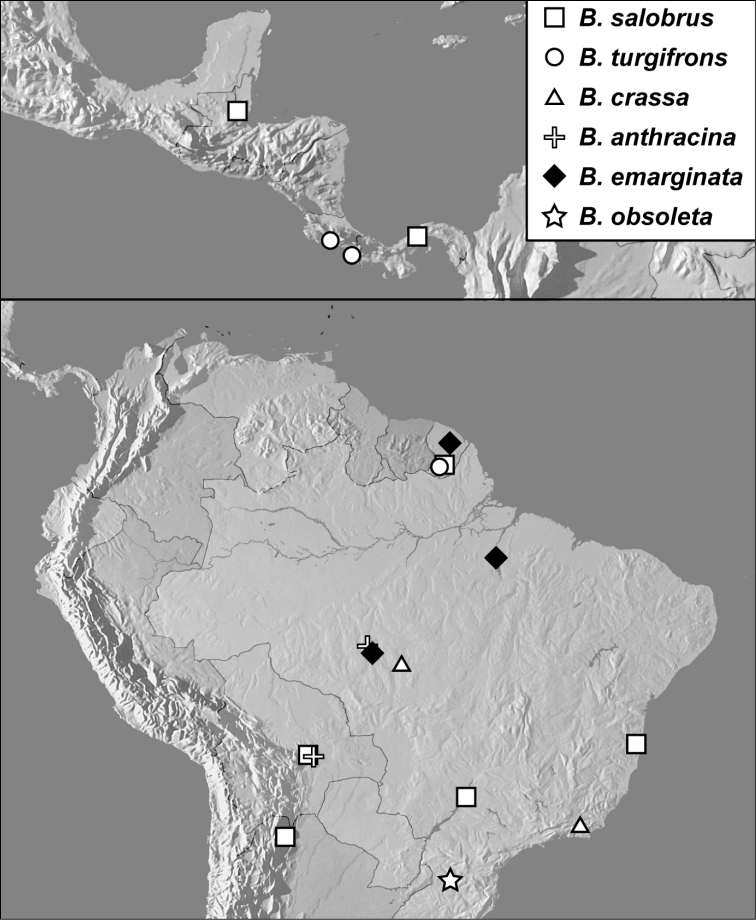
Baconia salobrus group records.